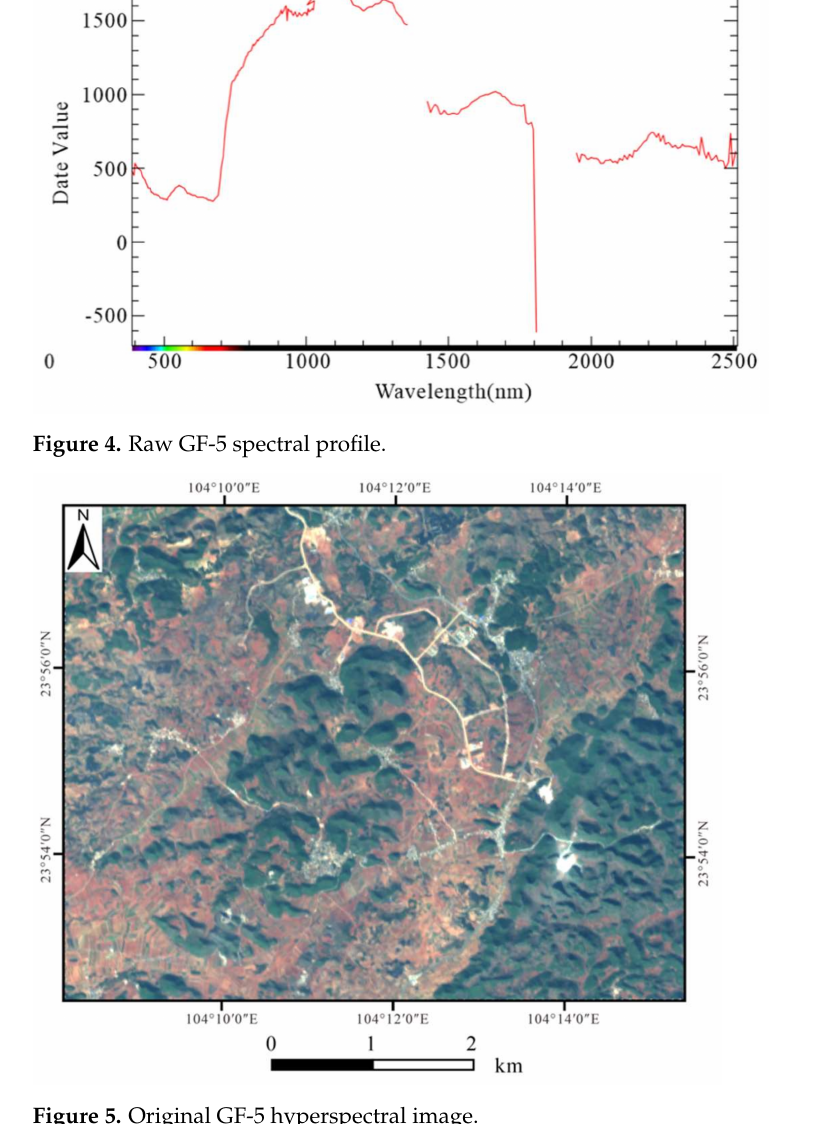
Figure 5. Original GF-5 hyperspectral image.